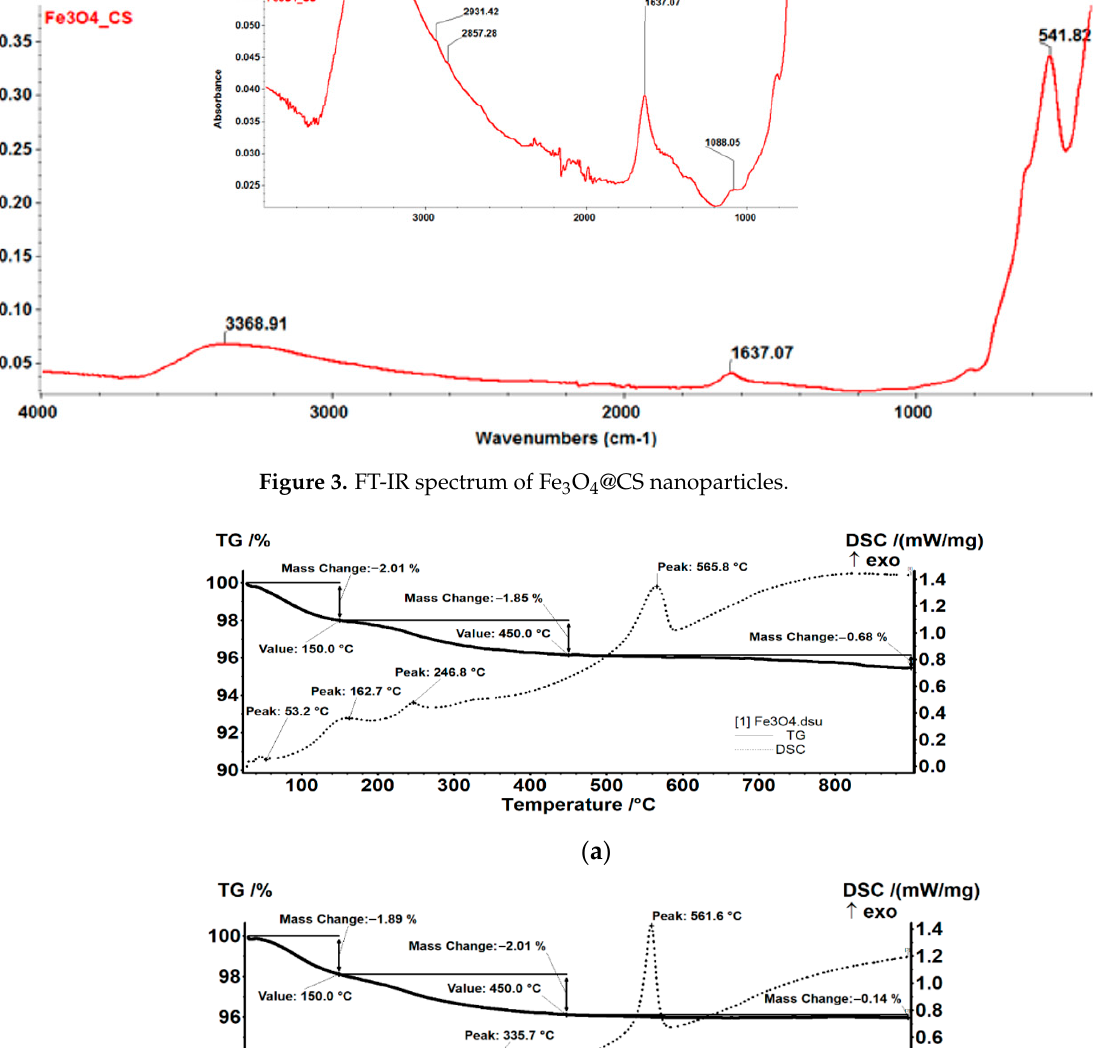
Figure 3. FT-IR spectrum of Fe 3 O 4 @CS nanoparticles.